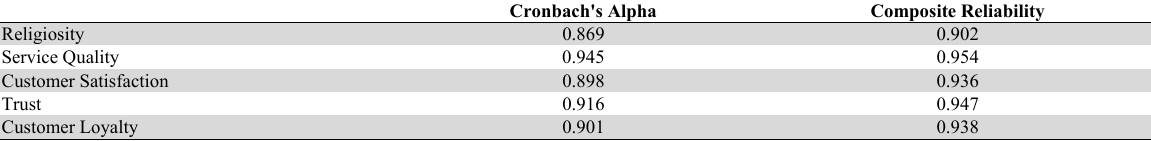
Cronbach’s Alpha and Composite